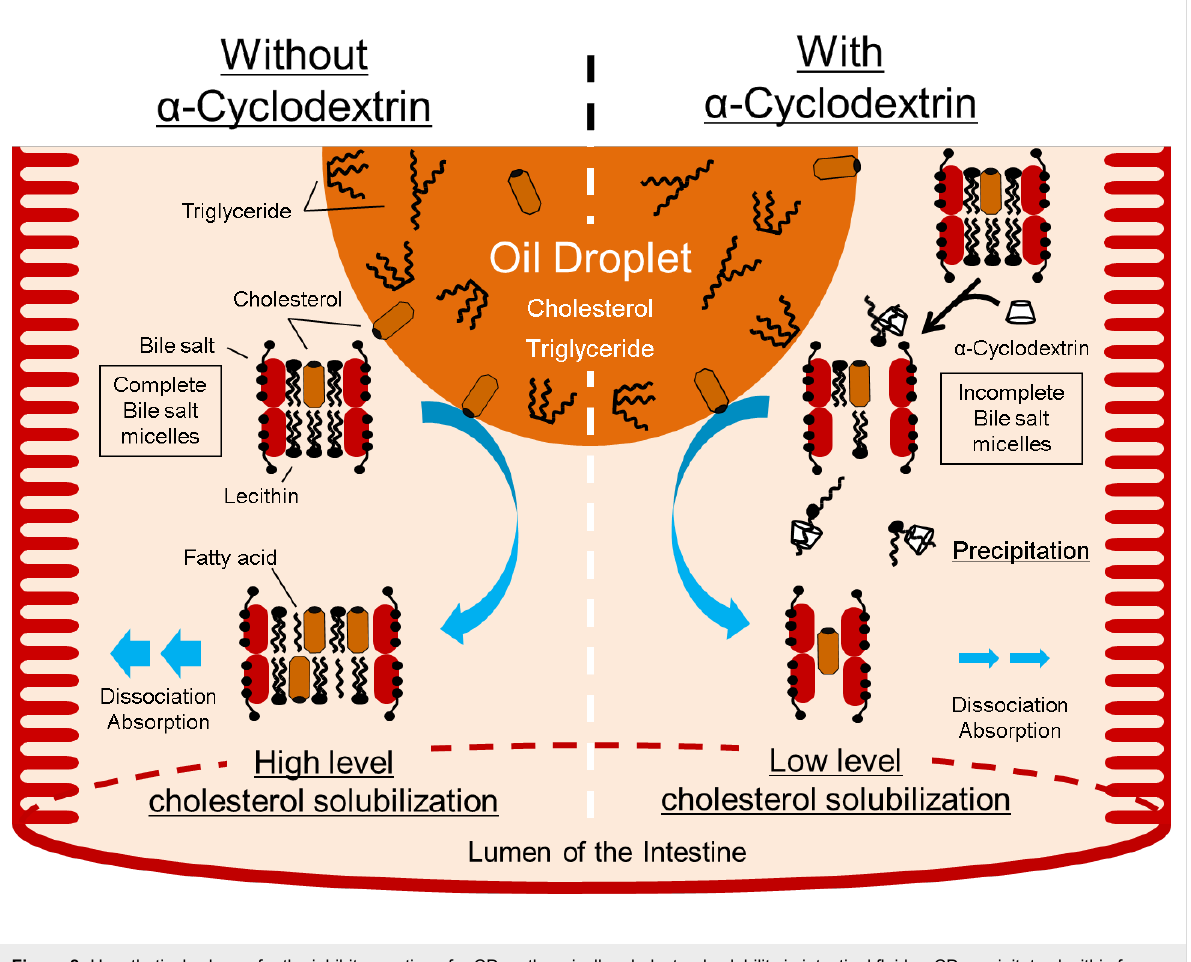
Figure 8: Hypothetical scheme for the inhibitory action of α -CD on the micellar cholesterol solubility in intestinal fluid. α -CD precipitates lecithin from bile salt micelles within the lumen of the small intestine and thereby indirectly decreases the micellar solubility of cholesterol.